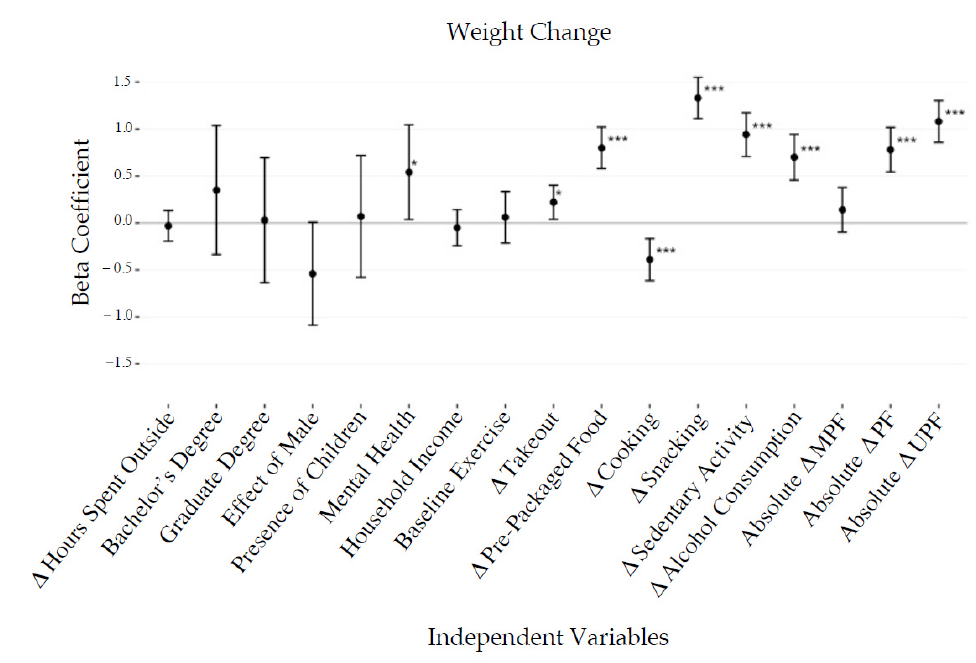
Figure 2. Combined stepwise linear regression outputs presenting the relationships between behavioral, demographic, and anthropometric factors to change in percent calories from minimally processed (MPF), processed (PF), and ultra-processed foods (UPF). This analysis was conducted in six separate models for each type of calorie, separating factors into either demographic/anthropometric factors or behavioral factors. Changes in alcohol consumption, sedentary activity, cooking, takeout food consumption, baseline exercise, and ready-to-eat packaged food consumption were included in the behavioral model, while the remaining variables were included in the demographic/anthropometric model. Factors dropped from models are not shown. Results are presented as beta coefficients with 95% confidence intervals. * p < 0.05, ** p < 0.01, *** p < 0.001.